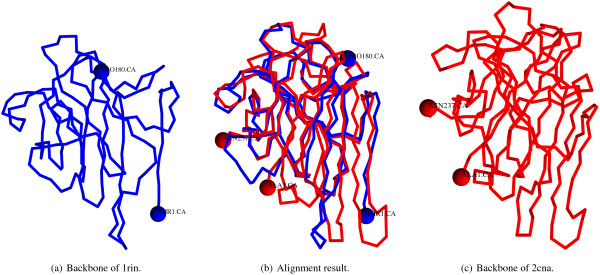
The comparison result of a naturally occurring protein pair 1RIN/180 and 2CNA/237 by SAMO. The subfigures (a) and (c) are backbone of proteins 1RIN and 2CNA respectively. The subfigure (c) illustrates the aligned result after the optimal superimposing by different colors. The red chain is 2CNA and the blue chain is 1RIN. The two termini of the two structures are indicated by labeling their residue names respectively. Notice that the termini of the blue chain (1RIN) are aligned to the middle of the red chain (2CNA) and vice versa.